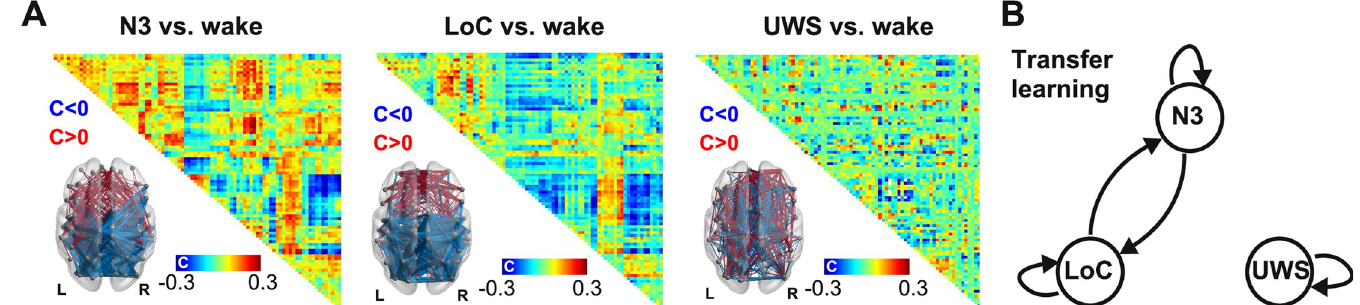
Fig 2. Significant transfer learning accuracy between physiological and pharmacologically-induced states of unconsciousness (N3 sleep and LoC), but not between them and pathological states of unconsciousness (UWS). (A) Average across subject FC differences for N3 vs. wake (left), LoC vs. wake (center), and UWS vs. wake (right), together with anatomical renderings of the top (red) and bottom (blue) 5% functional connections associated with the largest difference between states in absolute value. (B) Nodes in the diagram represent different brain states (N3, LoC, and UWS) and the arrows between them indicate that a machine learning classifier trained to distinguish the source state from W presented significant transfer learning accuracy when distinguishing the target state from W (p < 0.05, random label shuffling with 1000 iterations, Bonferroni corrected).